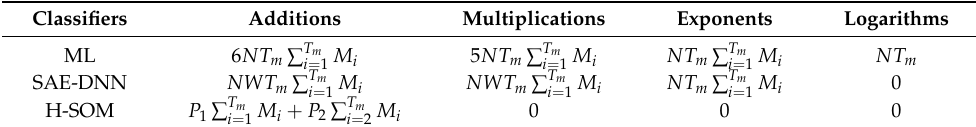
Table 3. Computational requirements of different